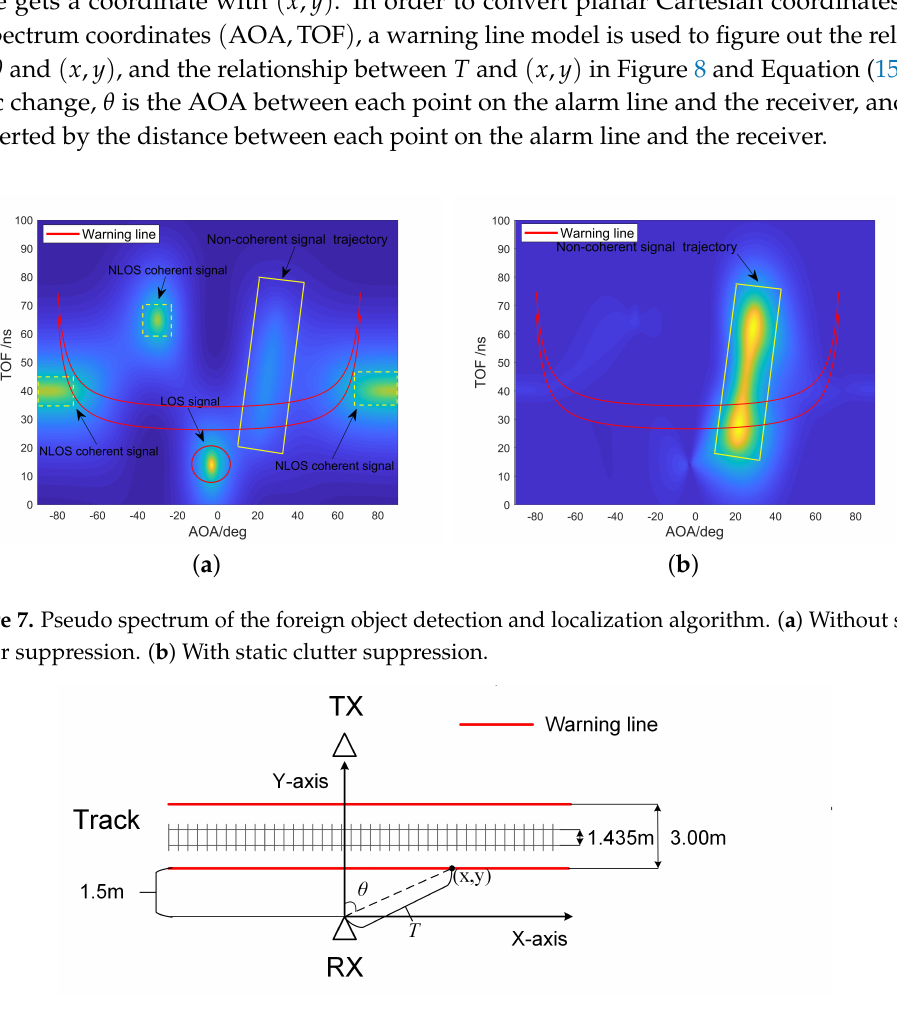
Figure 8. Warning line